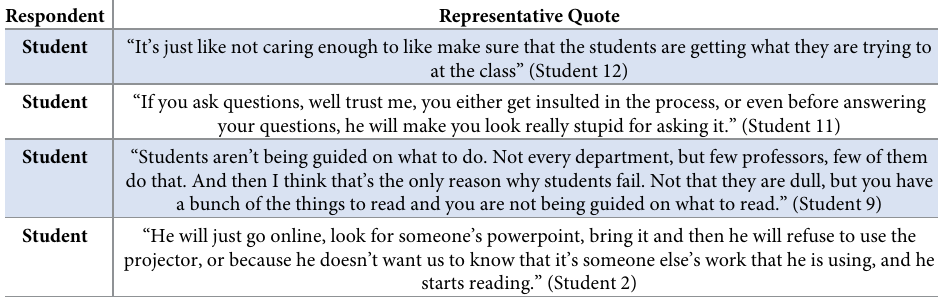
Table 2. Student reports of ineffective teaching tactics